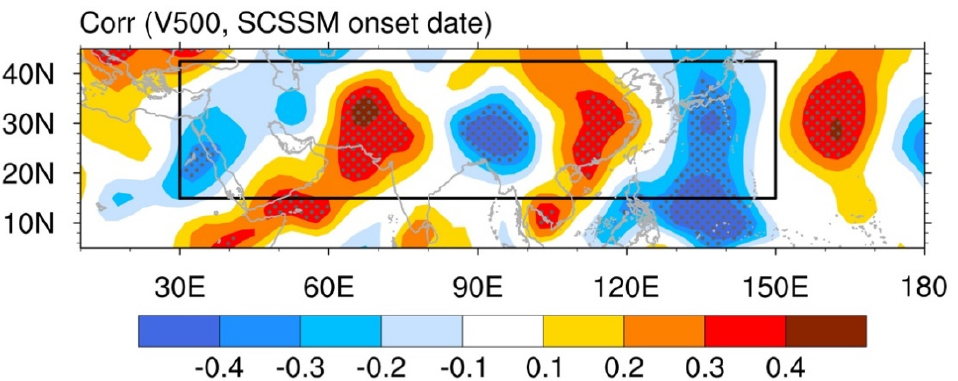
Figure 2. Correlation coefficients between meridional wind anomalies at 500 hPa in May and the normalized time series of the SCSSM onset date for the period of 1979–2018. Dotted areas indicate that the correlation coefficients are significant at the 95% confidence level. The black rectangle denotes the region (15° N–42.5° N, 30° E–150° E) applied to EOF analysis in Figure 3.